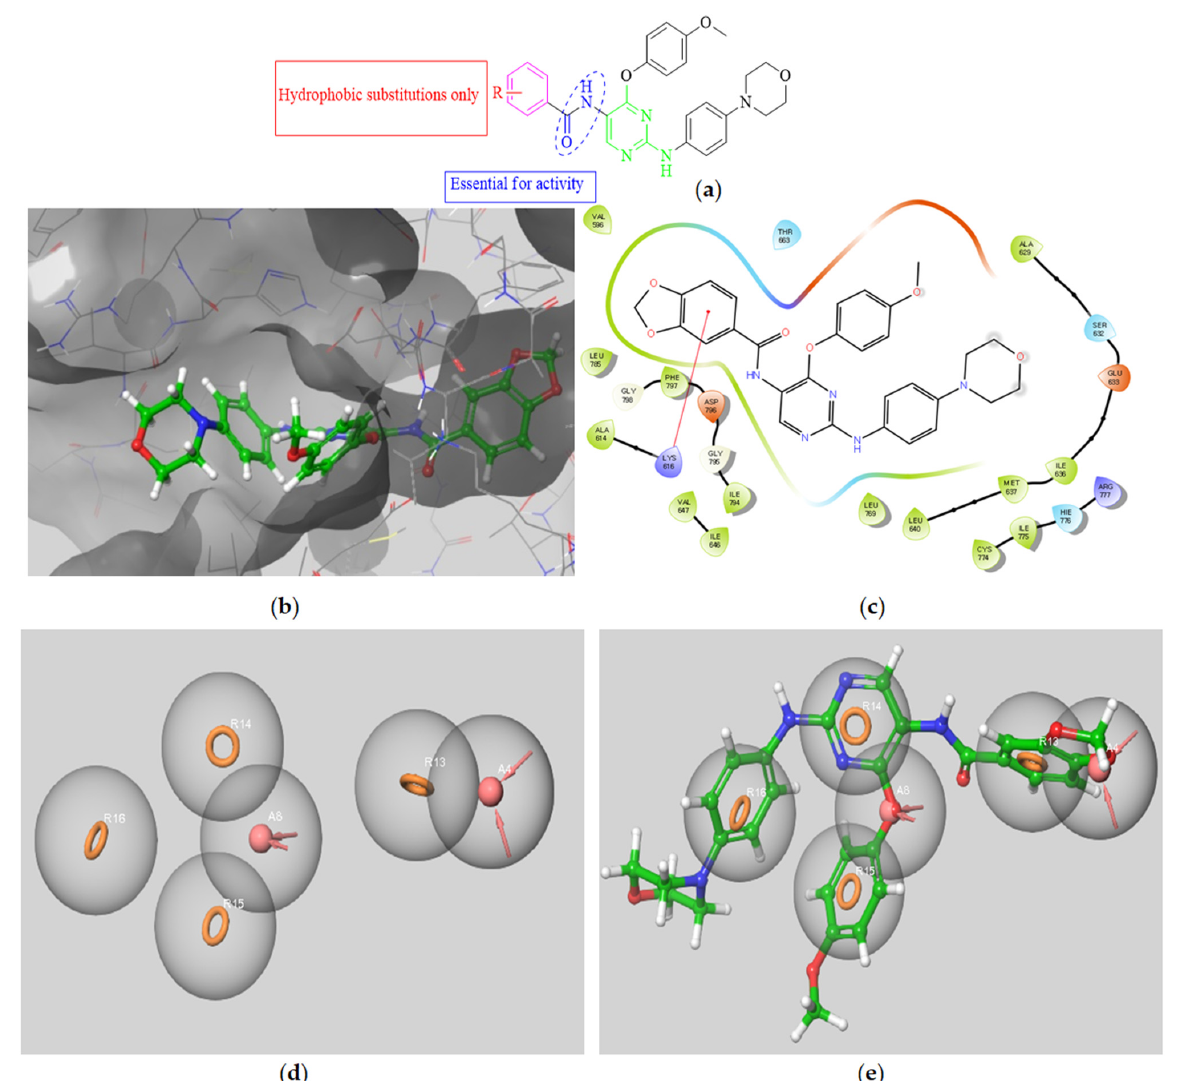
Figure 5. ( a ) General SAR of the synthesized compounds against FMS kinase. ( b ) 3D docking model of compound 5a into the FMS pocket. ( c ) 2D interaction diagram of compound 5a with FMS. ( d ) predicted hypothesis of the essential binding interactions using compound 5a as a reference. ( e ) compound 5a overlaid on the generated e-pharmacophore hypothesis. Molecular Docking Models within the DAPK1 Binding Site All synthesized compounds displayed almost similar inhibitory activity over DAPK1, with a range of percent inhibition varying from 65.5% ( 5f ) to 47.1% ( 5e ). This difference in activity could be explained due to the difference of their binding modes to the active site residue. Compound 5f formed one salt bridge and four hydrogen bonds, two of these hydrogen bonds were formed via the oxygen of the morpholine ring with Asp161 and Phe162, while the other two hydrogen bonds were established via the nitro group which acted as a hydrogen bond acceptor for Glu100 and Asp103. On the other hand, the least active compound 5e was only able to form one hydrogen bond through the NH of the morpholino moiety with GLU143. The 2D predicted interaction diagram comparing both compounds 5f and 5e is demonstrated in Figure 6.